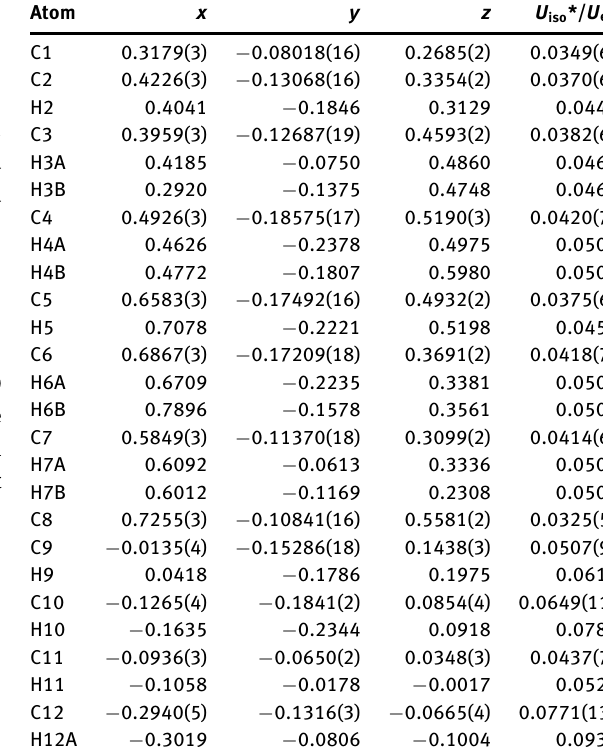
Table 2: Fractional atomic coordinates and isotropic or equivalent isotropic displacement parameters (Å 2